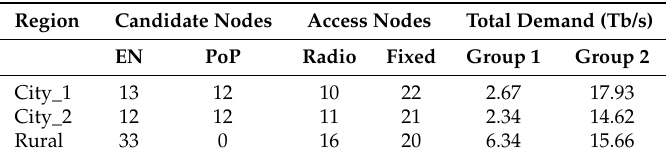
Table 6. Network nodes